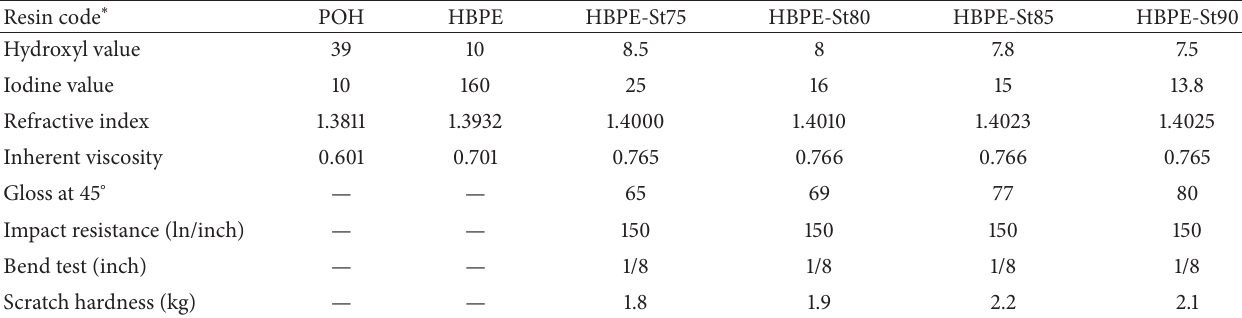
∗ Last numeral digit indicates the loading of